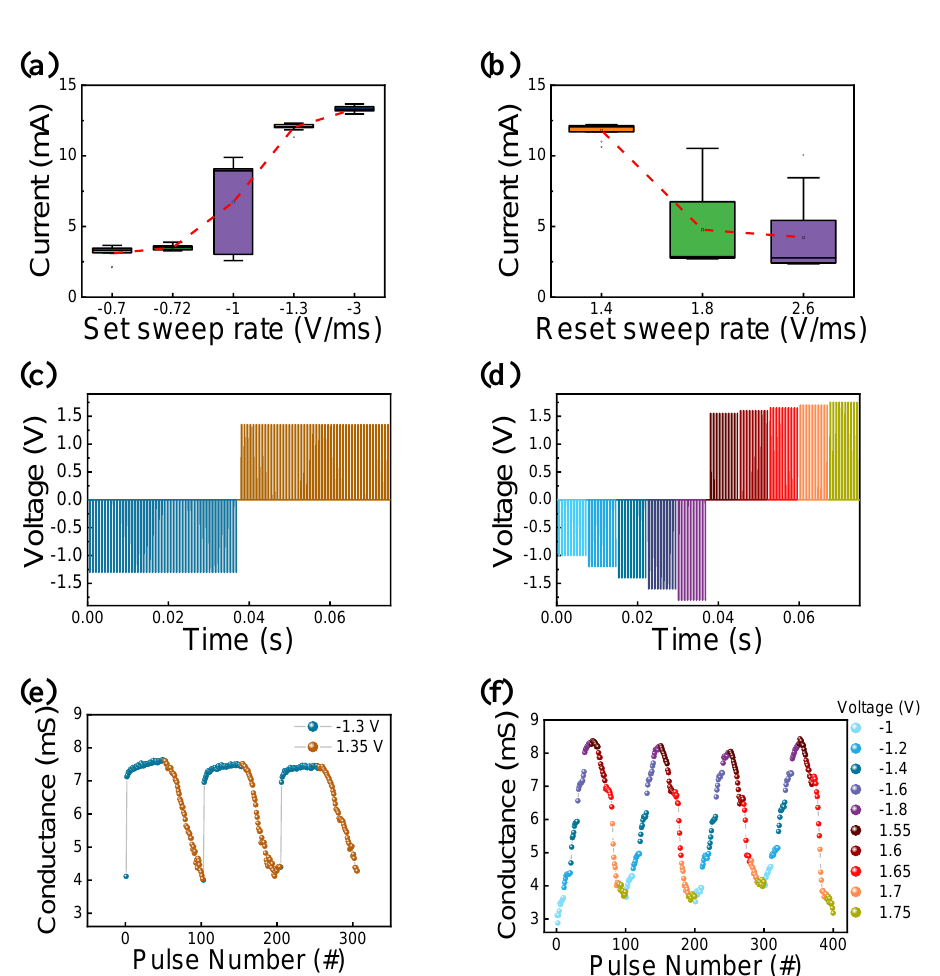
Figure 4. Current analysis by sweep rate V/t control: ( a ) LRS, ( b ) HRS. Potentiation and depression input voltage graph: ( c ) identical pulse segment type, ( d ) incremental pulse segment type. Potenti- ation and depression output conductance graph: ( e ) identical pulse segment type, ( f ) incremental pulse segment type.